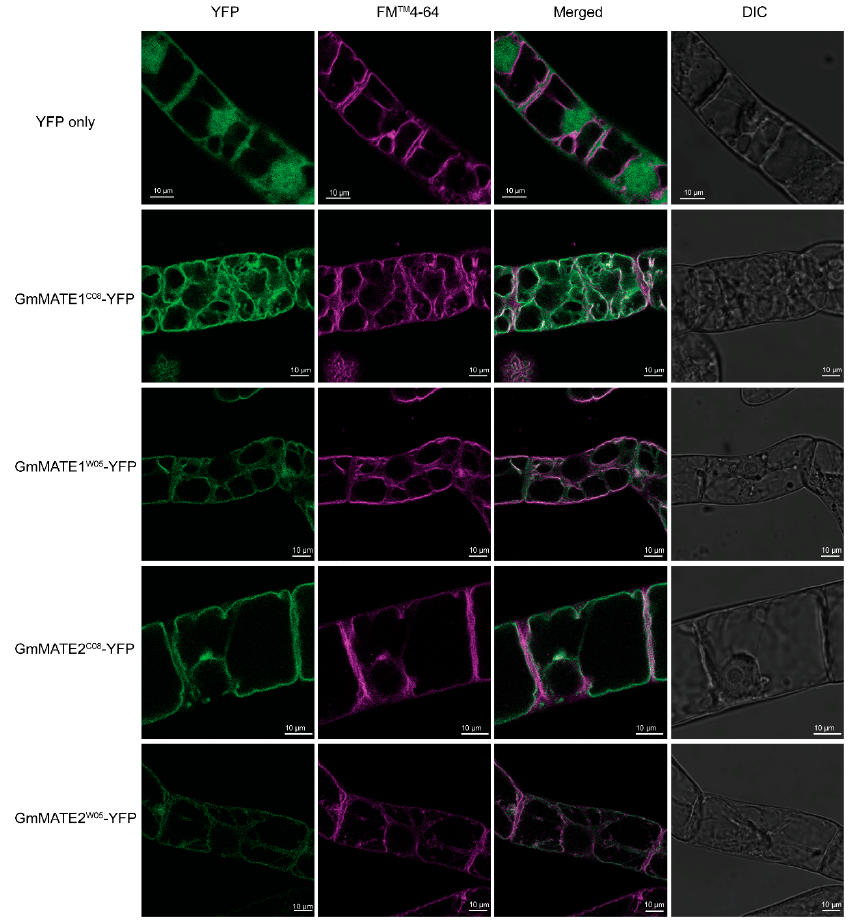
Figure 3. Subcellular localizations of GmMATE1-YFP and GmMATE2-YFP were determined using confocal microscopy. The cells were incubated with FM TM 4-64 in the dark at room temperature for 24 h before imaging. DIC, differential interference contrast. Signals from GmMATE-YFP and FM TM 4-64 were illustrated in green and magenta, respectively. Based on the results of yeast uptake assays and subcellular localization studies, the allelic differences between W05 and C08 did not seem to result in the differential accumu- lation of isoflavones between GmMATE W05 and GmMATE C08 expressing yeasts. Therefore, only the C08 allelic form was employed in subsequent functional analyses.